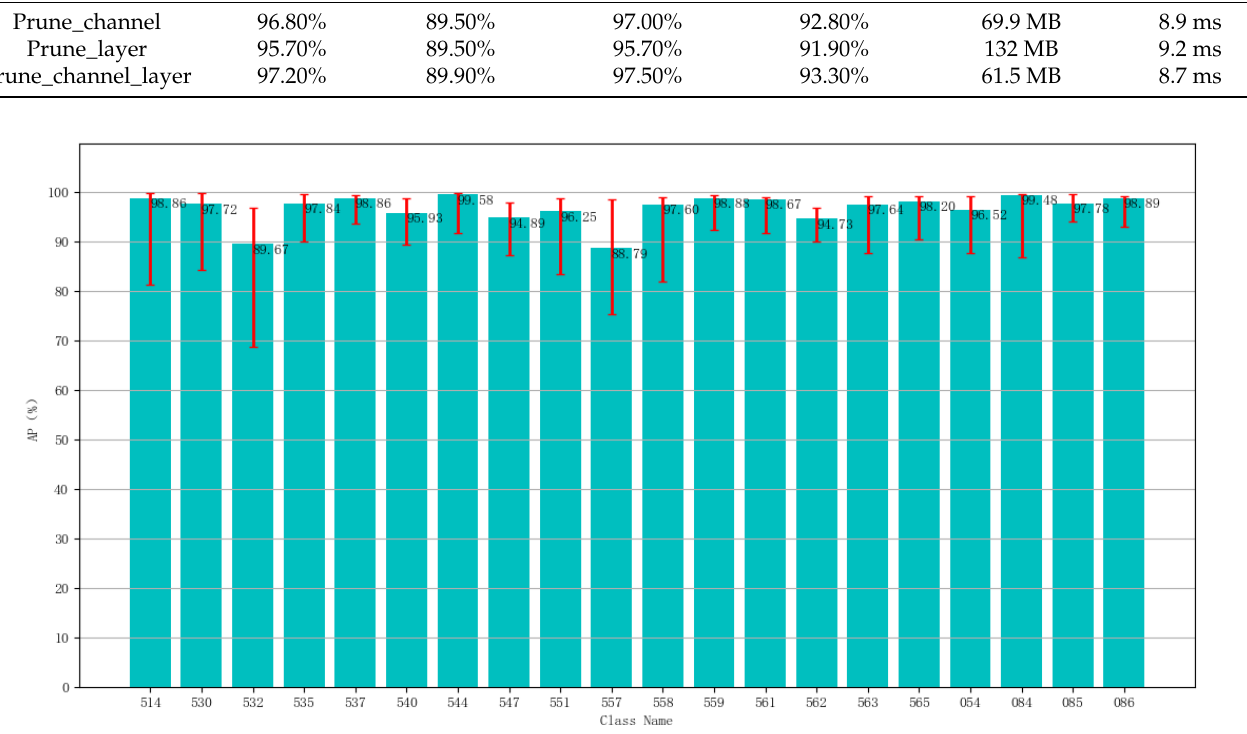
Figure 11. 10-fold cross-validation results of our model.